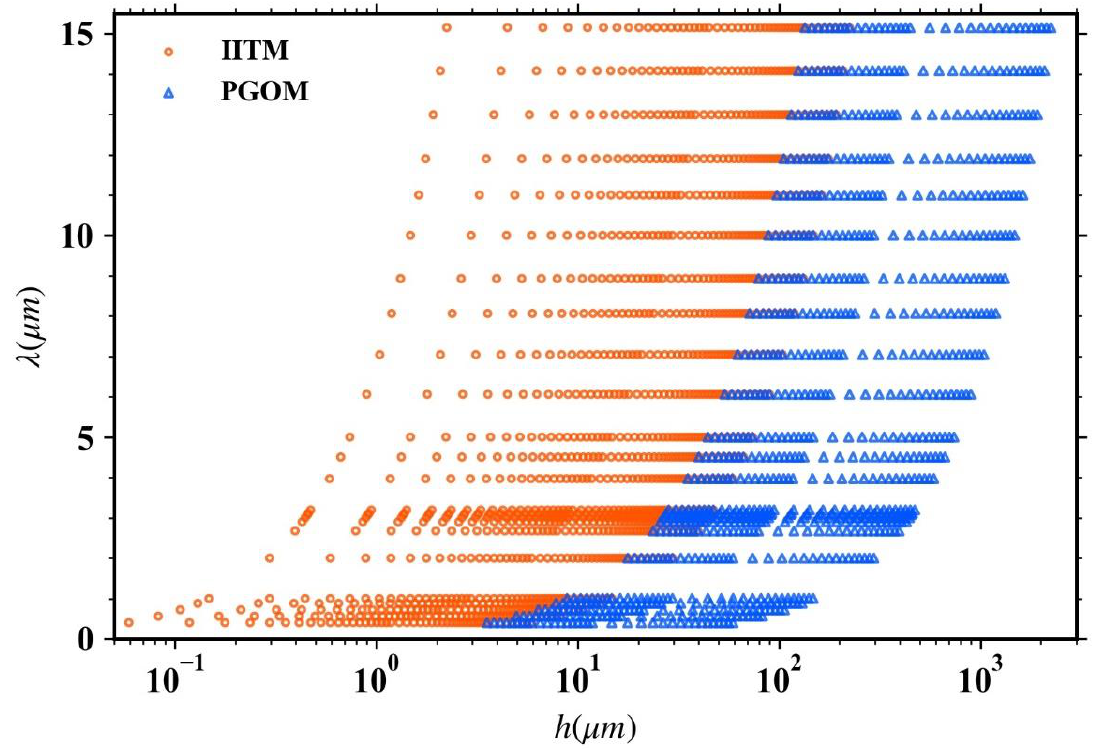
Figure 2. Scatter plot of the corresponding particle vertical heights with various size parameters and selected wavelengths listed in Table 1. selected wavelengths listed in Table